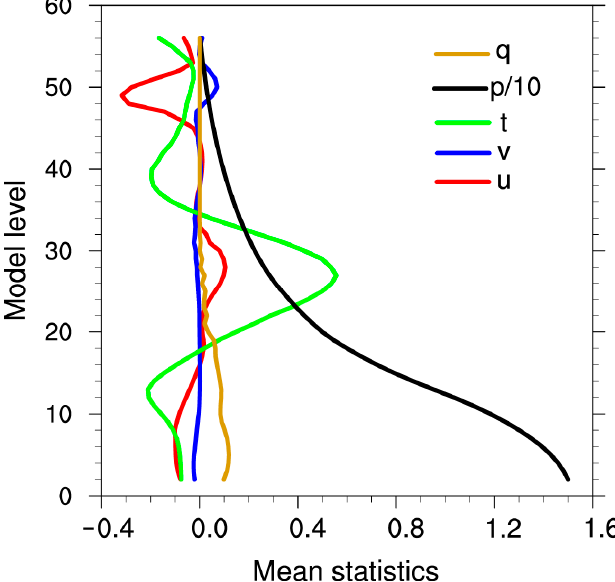
Figure 10. Vertical profiles of the mean increment for different model variables at 0600 UTC 8 August 2019.